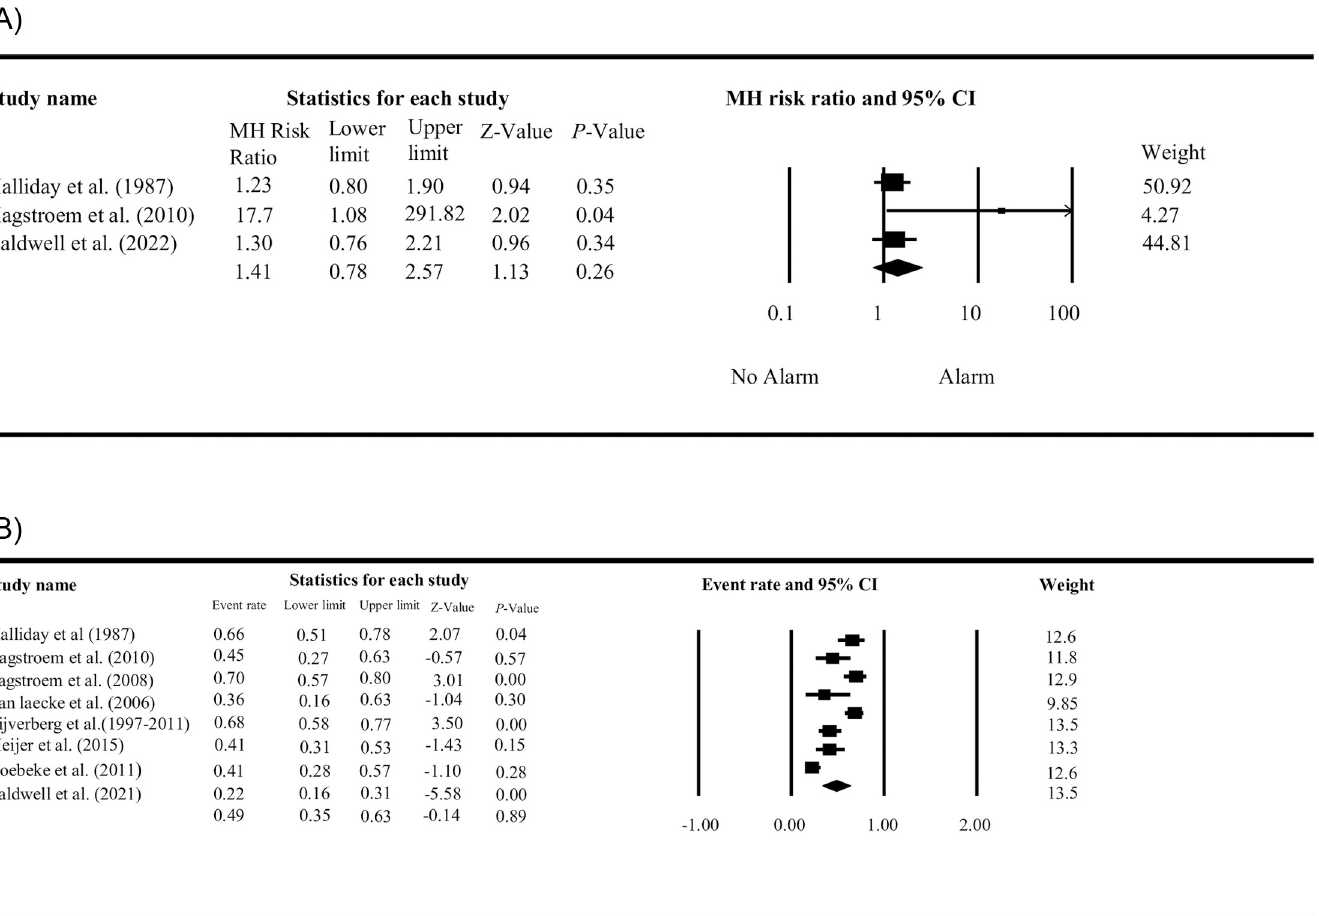
Fig 3. A. Random effect model for all included RCTs with a risk ratio for continence after training. B. Random effect model including all studies for continence after